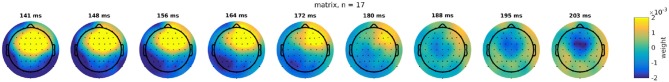
The topography of the attention condition using the Matrix data between 141 and 203 ms.